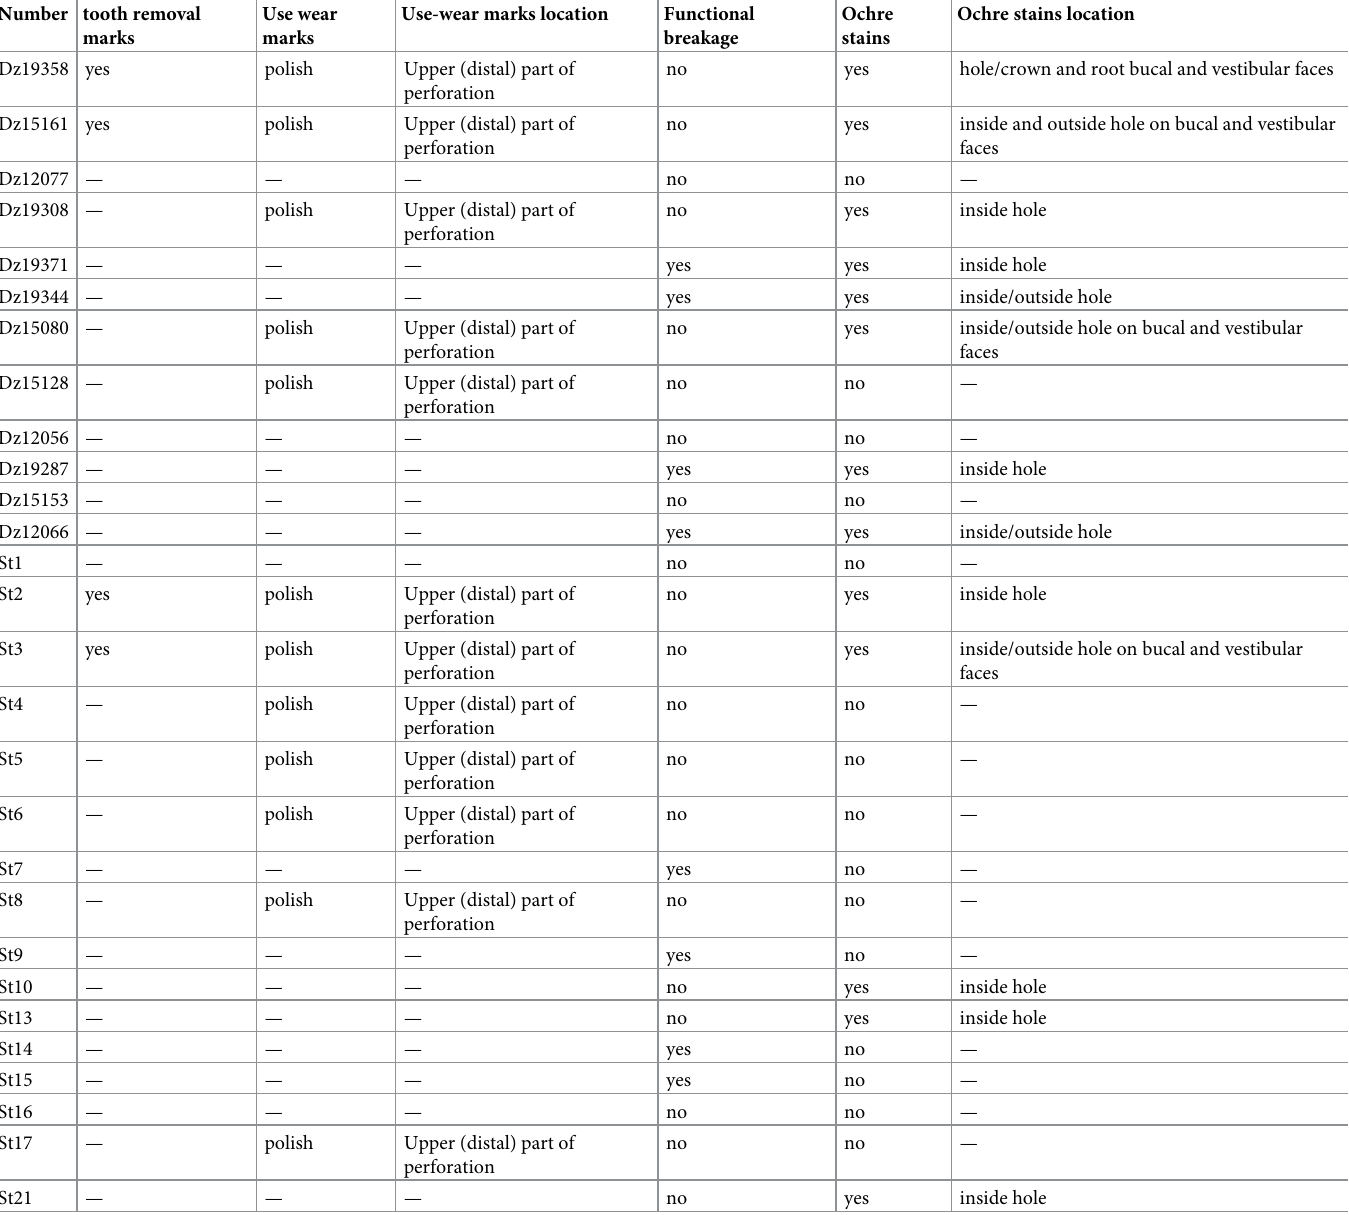
Table 4. Tooth removal marks, use-wear marks, functional breakages and ocher stains. Number tooth removal Use wear marks